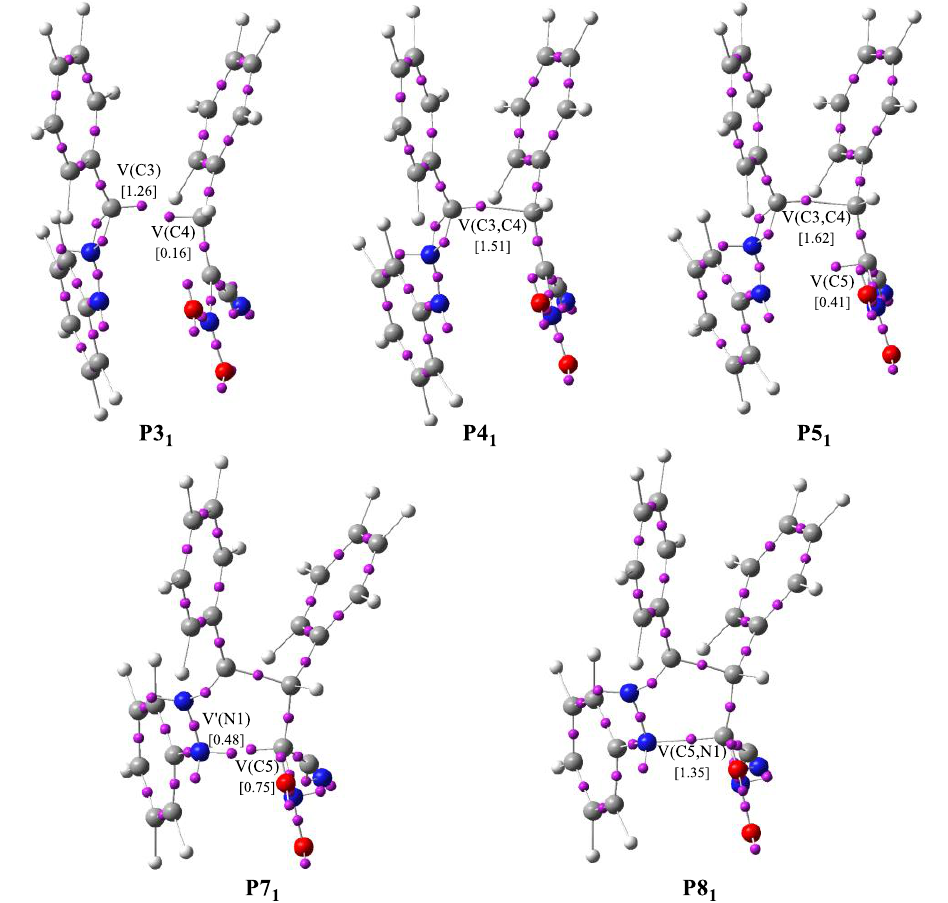
Figure 4. The main ELF valence basin populations for the points P3 1 – P5 1 , P7 1 and P8 1 participating in the 32CA reaction of the 1a and 2a . On the grounds of the BET study, we gather that: (i) the 32CA reaction between C,N- diphenylnitrylimine 1a and (E)-2-phenyl-1-cyano-1-nitroethene 2a can be depicted by nine topologically various phases; (ii) the activation energy of this reaction, 4.0 kcal · mol − 1 , is related to the formation of C4 pseudoradical center and lone pair at N2 nitrogen